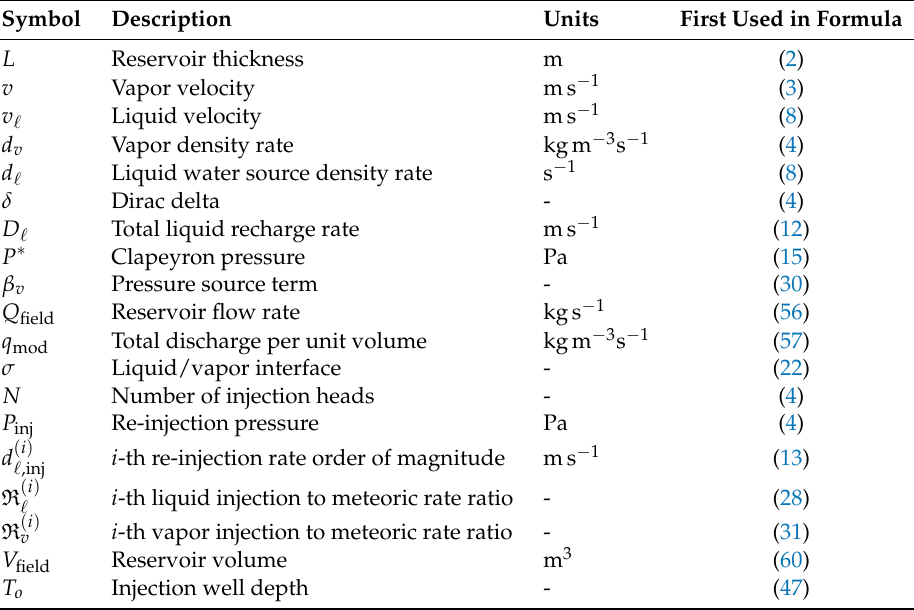
Table 3. Nomenclature and other symbol